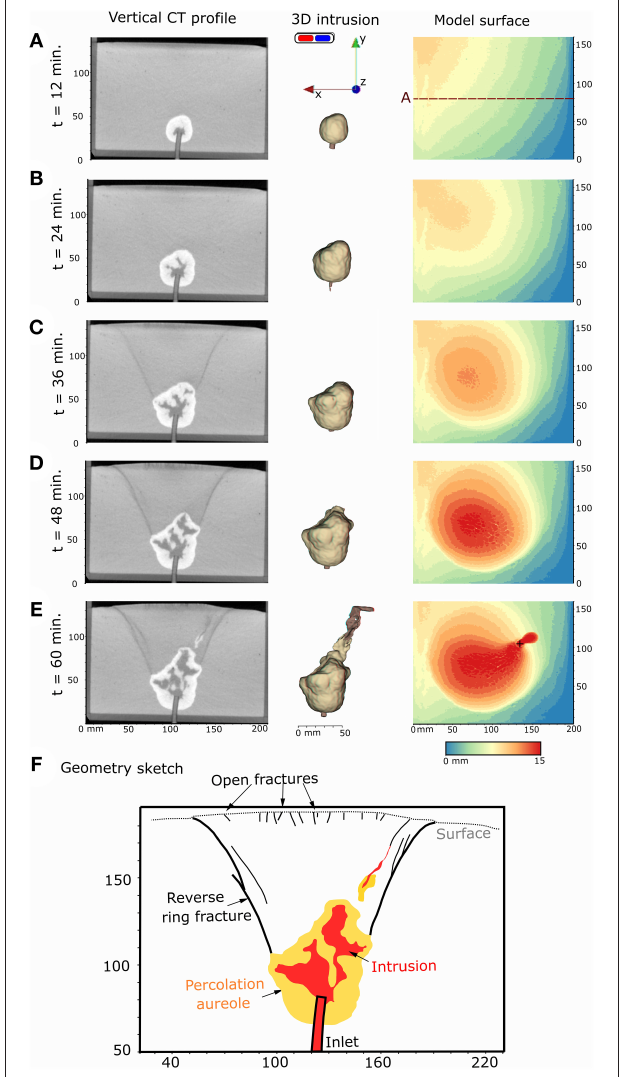
FIGURE 5 | (A–E) Temporal evolution of a cryptodome intrusion in a 90:10 wt% sand:plaster mixture (SPCTIN02 in Table 2 ); (Left column) vertical x-y slice of reconstructed CT volumes through the model center; Central column: 3D anaglyphs of the intrusion geometry, including both syrup (red), and the percolation aureole (yellow), rendered from CT images, to be viewed with blue-red 3D glasses; (Right column) Model surface elevation extracted from resampled CT images, the black cross marks where syrup broke through the surface (i.e., eruption); (F) Structural sketch of the final intrusion and induced deformation structures in the overburden through the central x-y slice in (E) ( t =